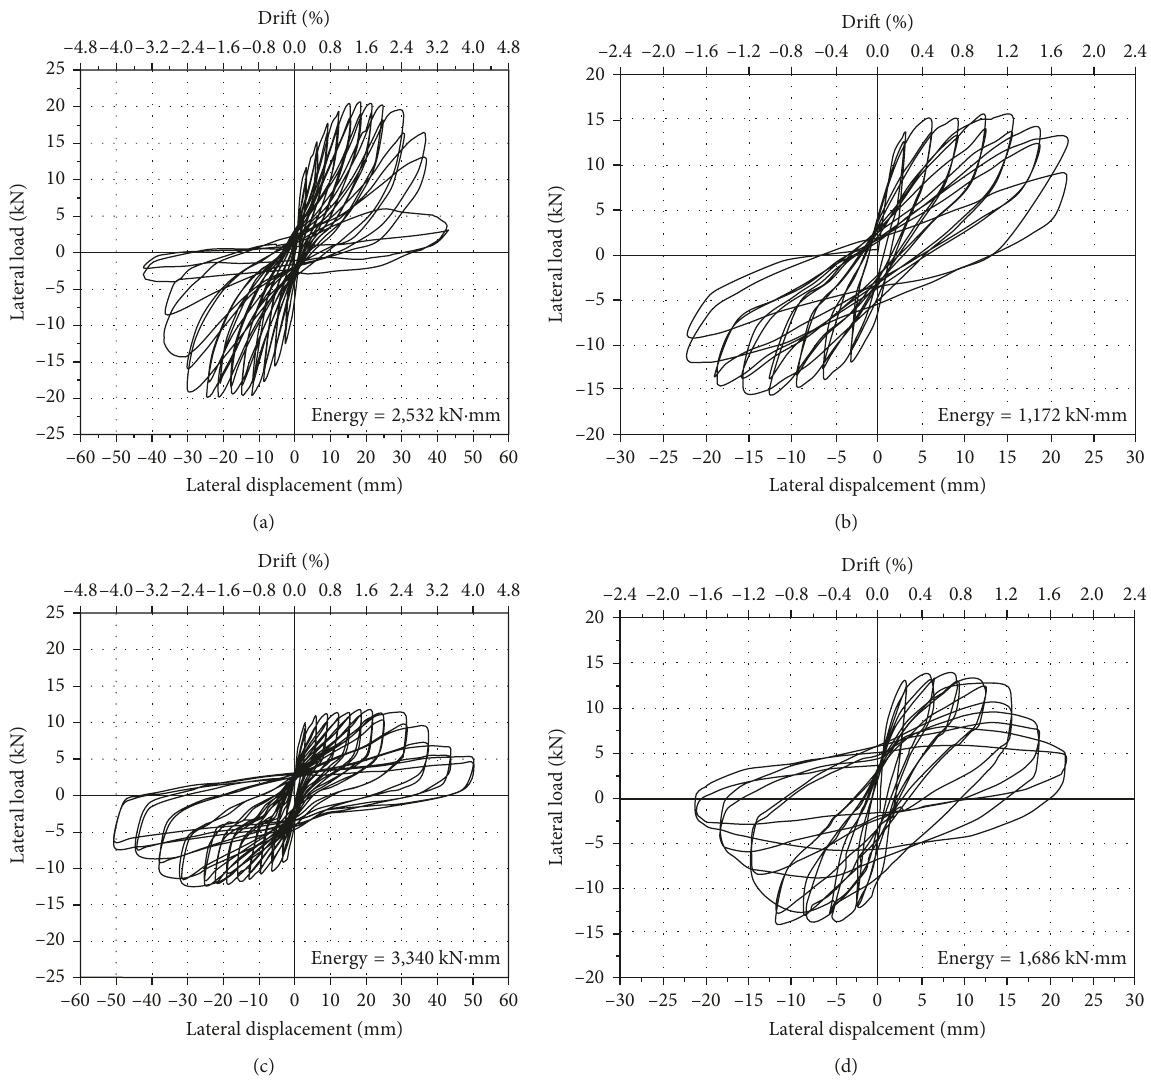
Figure 7: Lateral load-drift ratio responses. (a) 12L-0.2; (b) 12L-0.6; (c) 9L-0.2; (d)